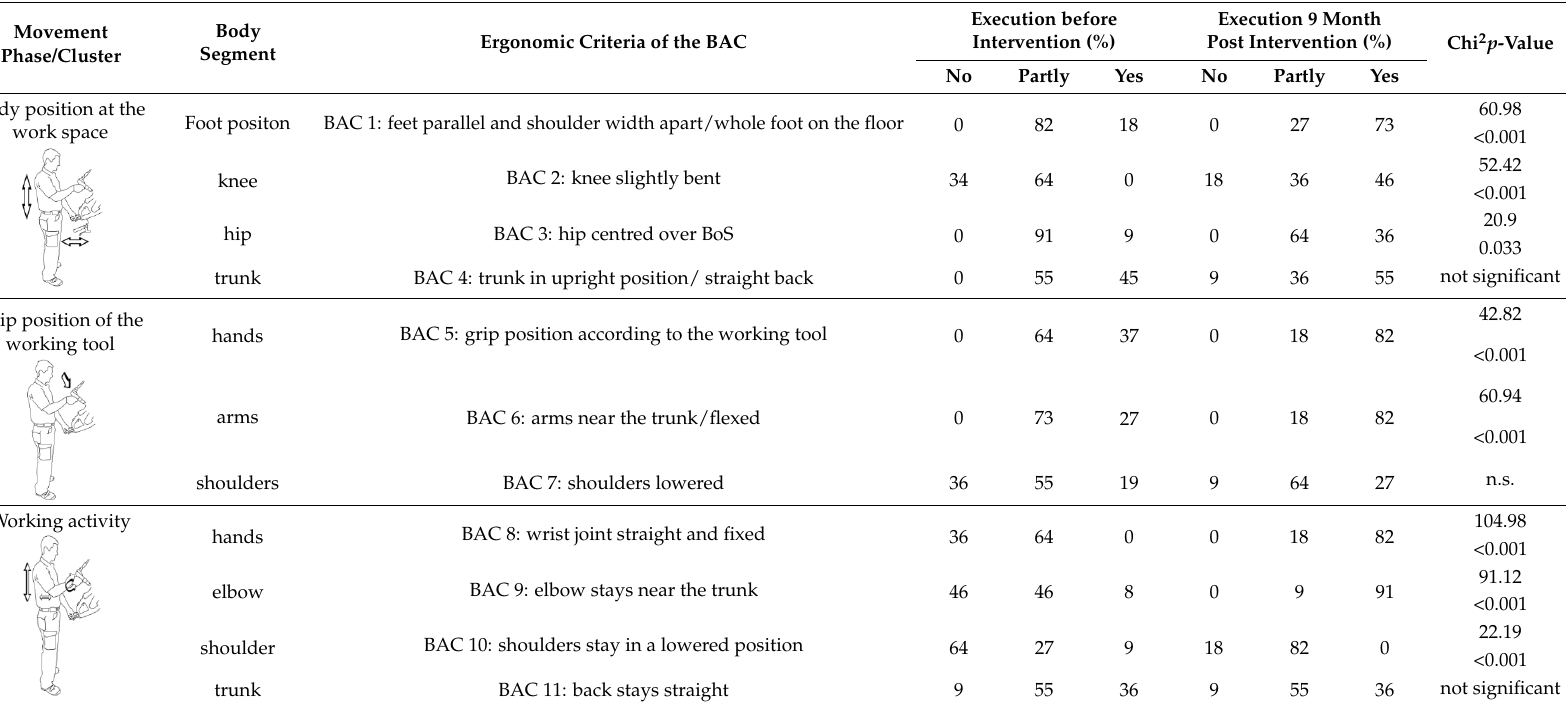
Table 4. Movement Analysis ( n = 21 pre-retention-test).